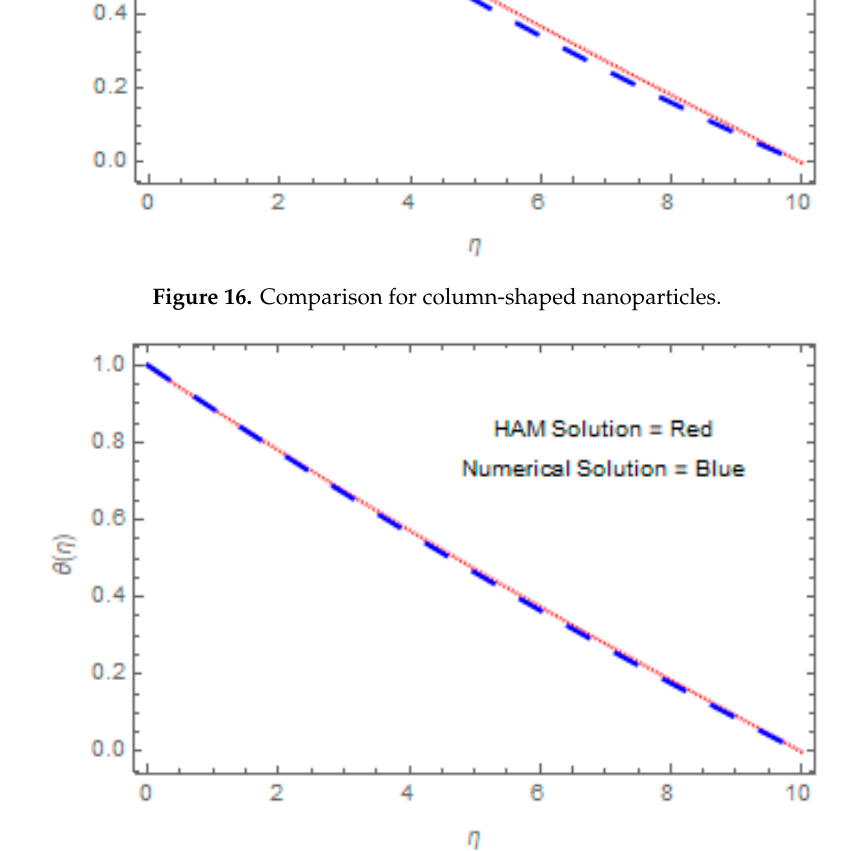
Figure 17. Comparison for lamina-shaped nanoparticles.